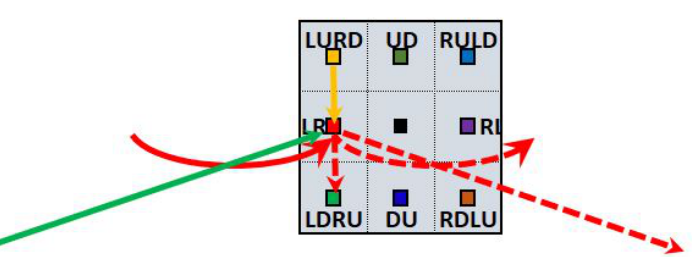
Figure 12. Depicts the three input edges (solid lines) and the three output edges (dashed lines) for an LR node. The colors of the edges are the same as their start nodes.